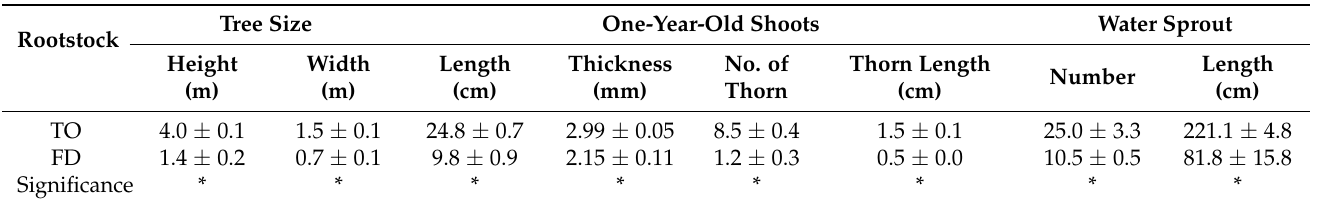
Table 1. Tree vegetative growth of ‘Minihyang’ mandarin grafted on trifoliate orange (TO) and Flying Dragon (FD)